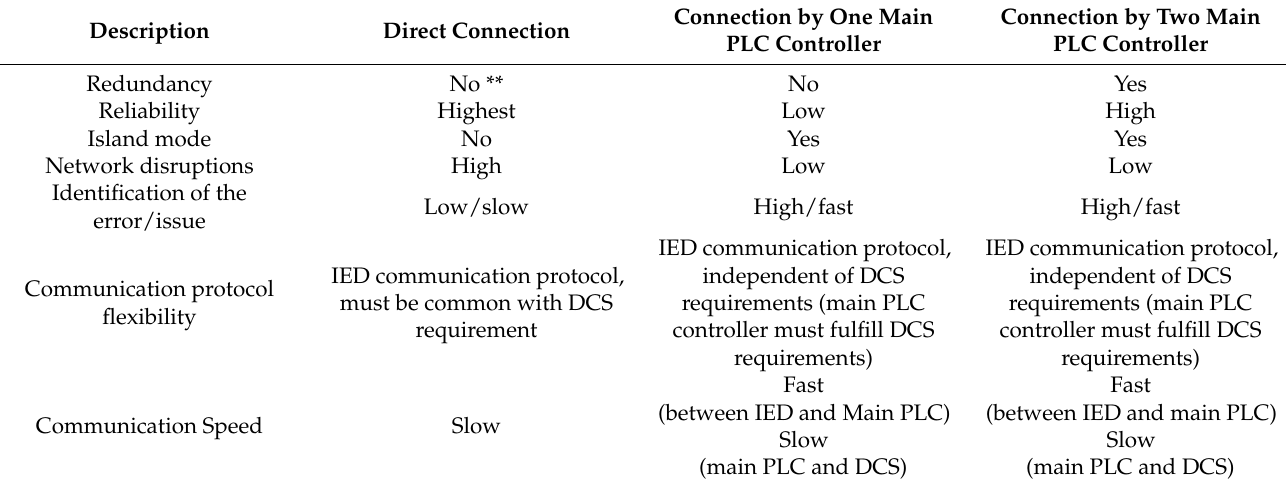
Figure 2. Topology of the indirect connection between the controller and the DCS supervision system via the main PLC. Table 1. Comparison of the three types of connection between PLC and DCS